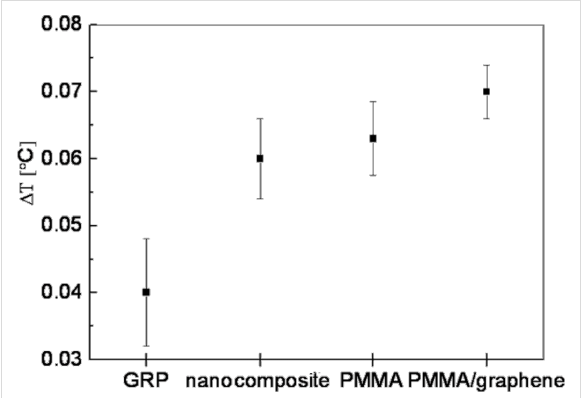
Figure 5: Comparison of the IRT temperature changes. The measure- ments were performed on various composite